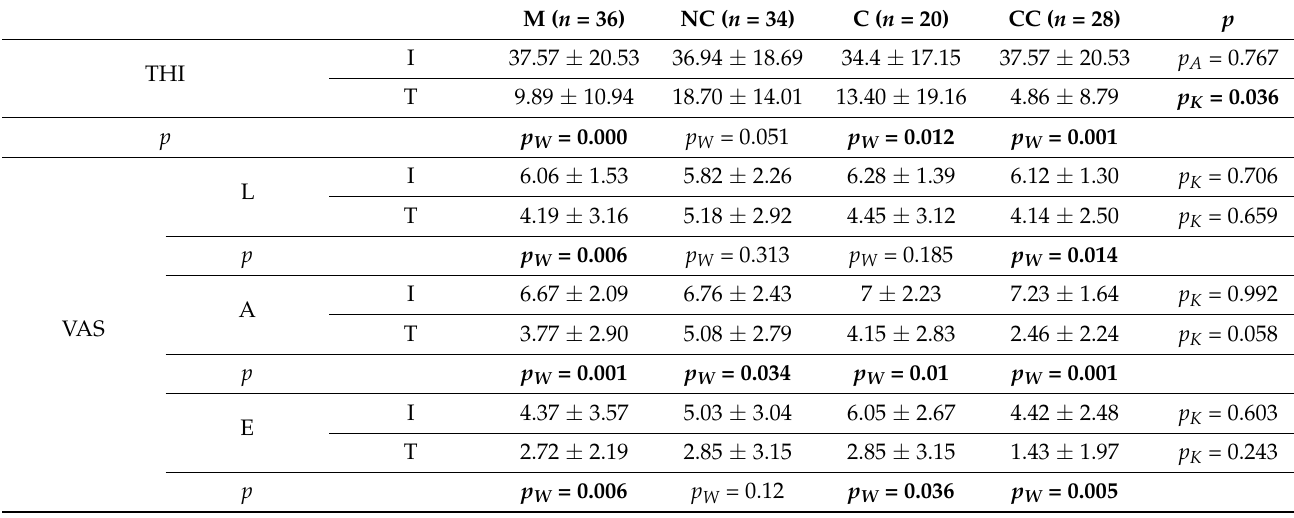
Table 2. Results from THI and VAS in the different groups at the beginning of TRT and during the telephone survey and associated statistical analysis.